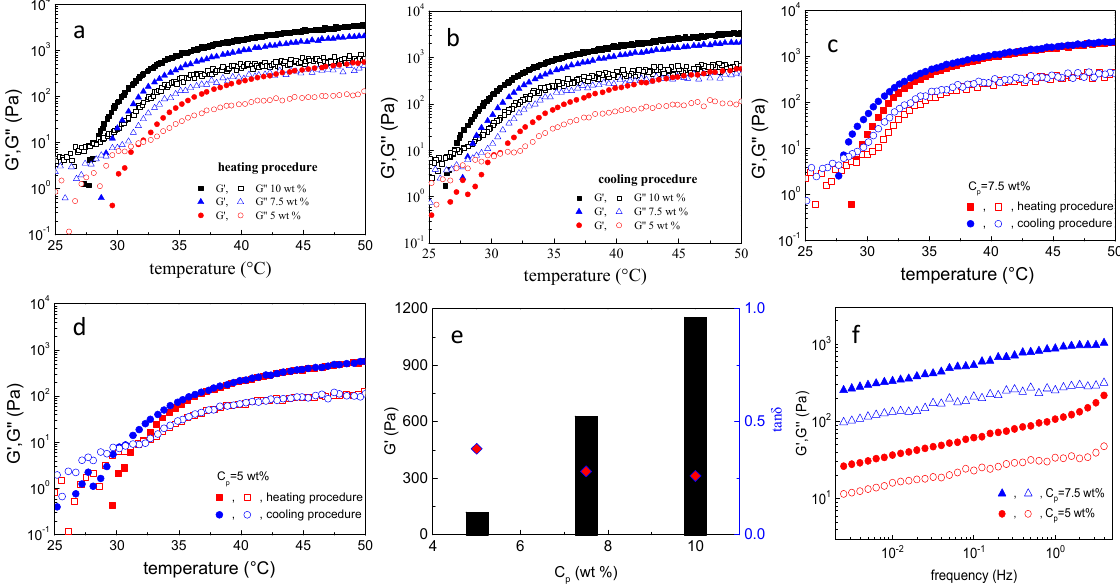
Figure 3. ( a ) Storage modulus G’ (solid symbols) and loss modulus G” (open symbols) at f = 1 Hz, γ = 0.1% and rate of 1 ◦ C/min at different C p as indicated: (a) heating procedure ( b ) cooling procedure, ( c ) cooling/heating cycle for C p = 7.5 wt% and ( d ) for C p = 5 wt%, ( e ) G’ and tan δ versus C p at 37 ◦ C extracted from the data of plot ( a ), ( f ) frequency dependence of G’ (solid symbols) and loss modulus G” (open symbols) at 37 ◦ C for C p = 7.5 wt% (triangles) and C p = 5 wt% (circles) for NaALG-g aqueous solutions.